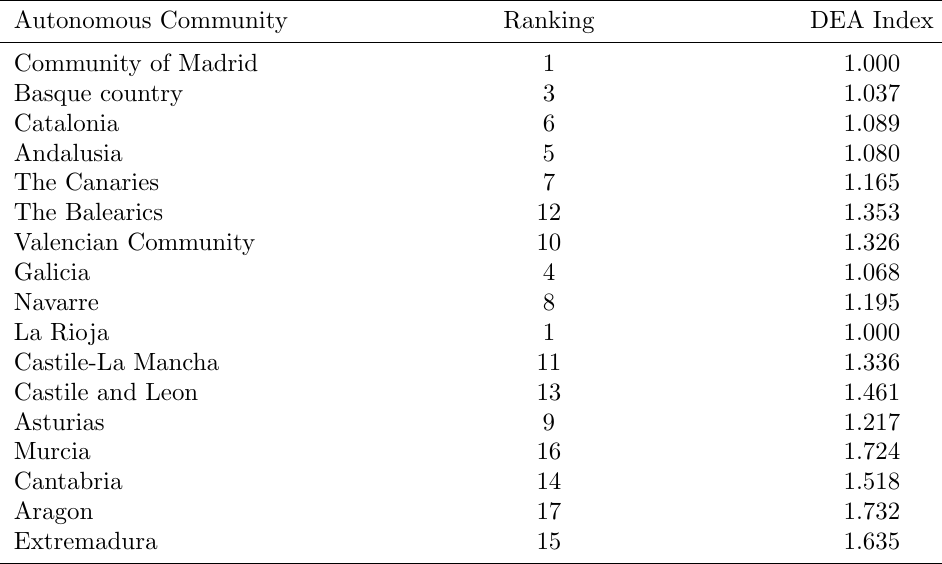
Table 3: DEA-MoniTUR index. Global